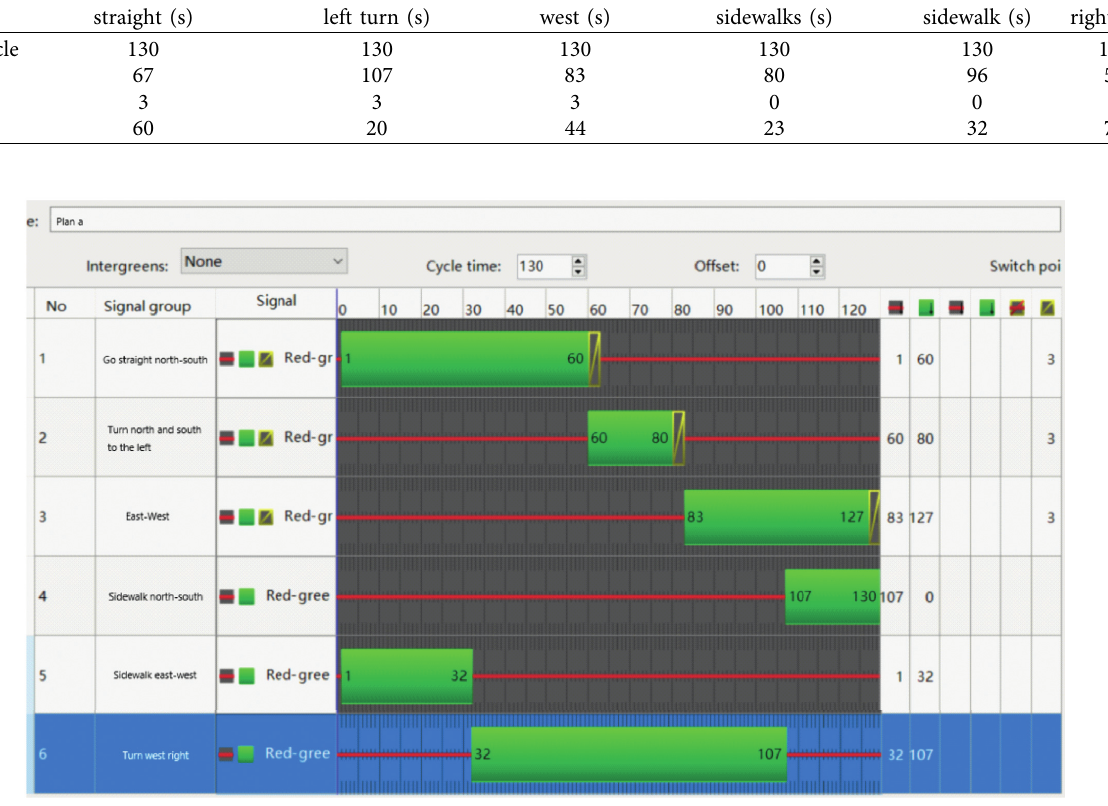
Figure 3: The signal control machine of